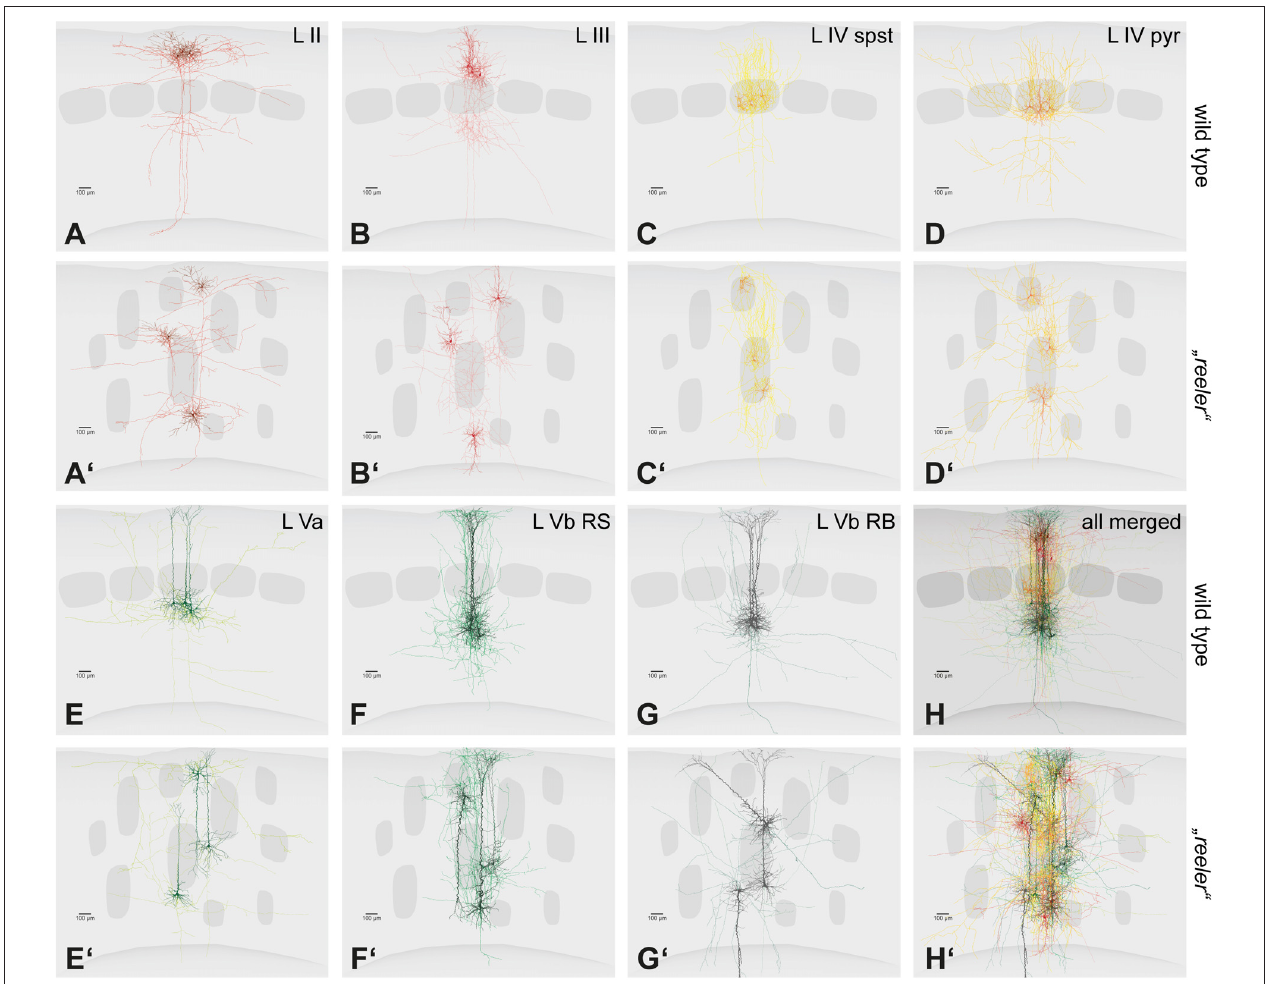
FIGURE 3 | Single cell fillings of excitatory neurons in the wild type and their hypothetical counterparts in the reeler cortex. (A–H) Principal cells of the barrel cortex ( n = 3 overlaid for each type) show typical layer-dependent organization of their dendritic and axonal arbors. Original data published (Schubert et al., 2003,